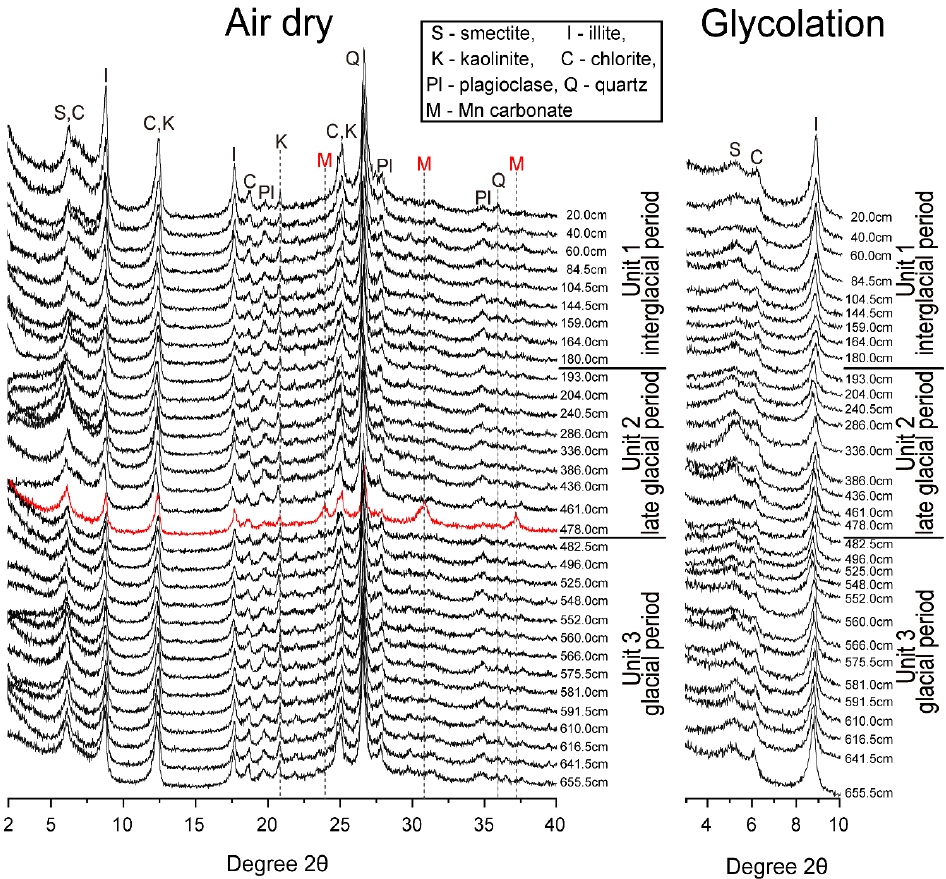
Figure 4. The XRD Patterns of Core Samples. Air dried and glycolation treatment for clay with depths. The red line indicates Mn carbonate. S = Smectite, I = Illite, K = Kaolinite, C = Chlorite, Pl = Plagioclase, Q = Quartz, and M = Mn carbonate.